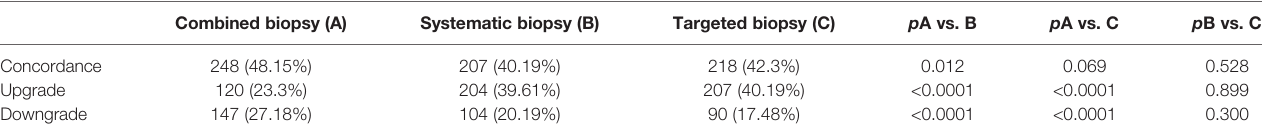
TABLE 2 | Concordance, upgrade, and downgrade of Gleason score according to different biopsy